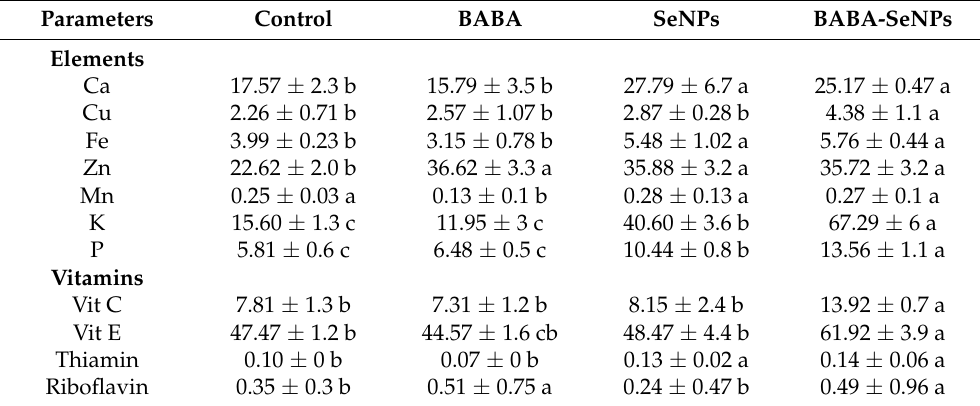
Table 2. Mineral elements (mg g − 1 FW) and vitamins (mg g − 1 FW) of control and BABA- and/or Se NPs- treated M. interexta sprouts. Data are represented by the means of four replicates ± standard deviations. Parameters Control BABA SeNPs